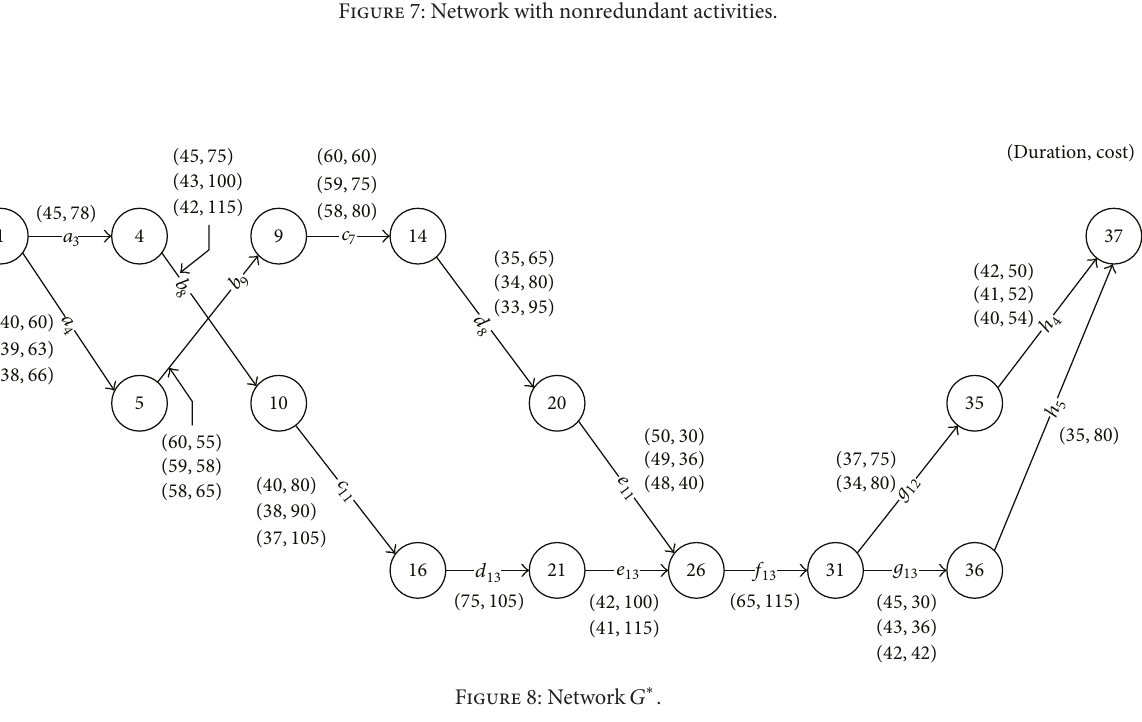
Figure 8: Network 𝐺 ∗